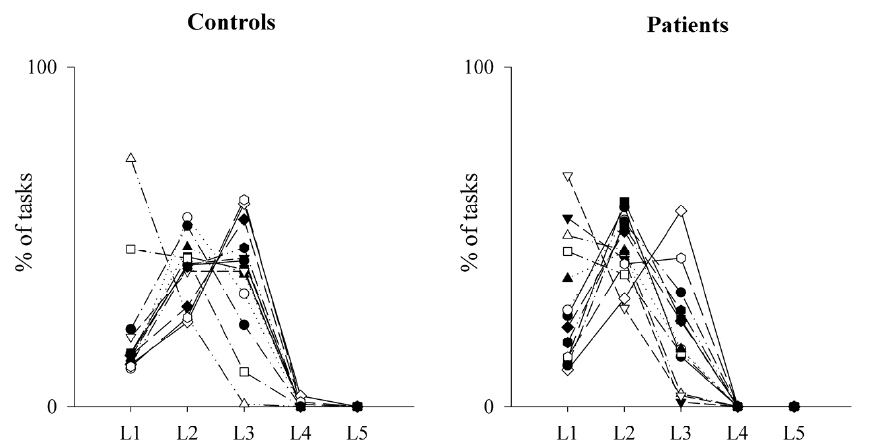
Figure 6. Trend of the performance on the MIST test as a function of the levels reached by healthy controls and PAH patients. The scatterplots show the percentage of tasks at each level of difficulty during the MIST session in healthy controls ( left panel) and PAH patients ( right panel). Level 1 (L1) is the easiest, while Level 5 (L5) is the most difficult one.